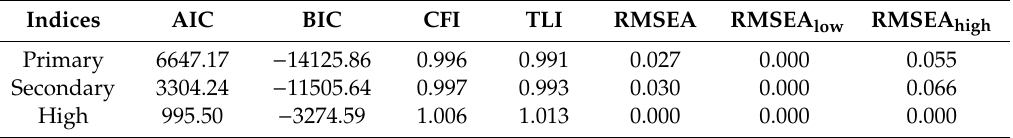
Table 3. Fit indices of Model 3 for primary, secondary, and high school